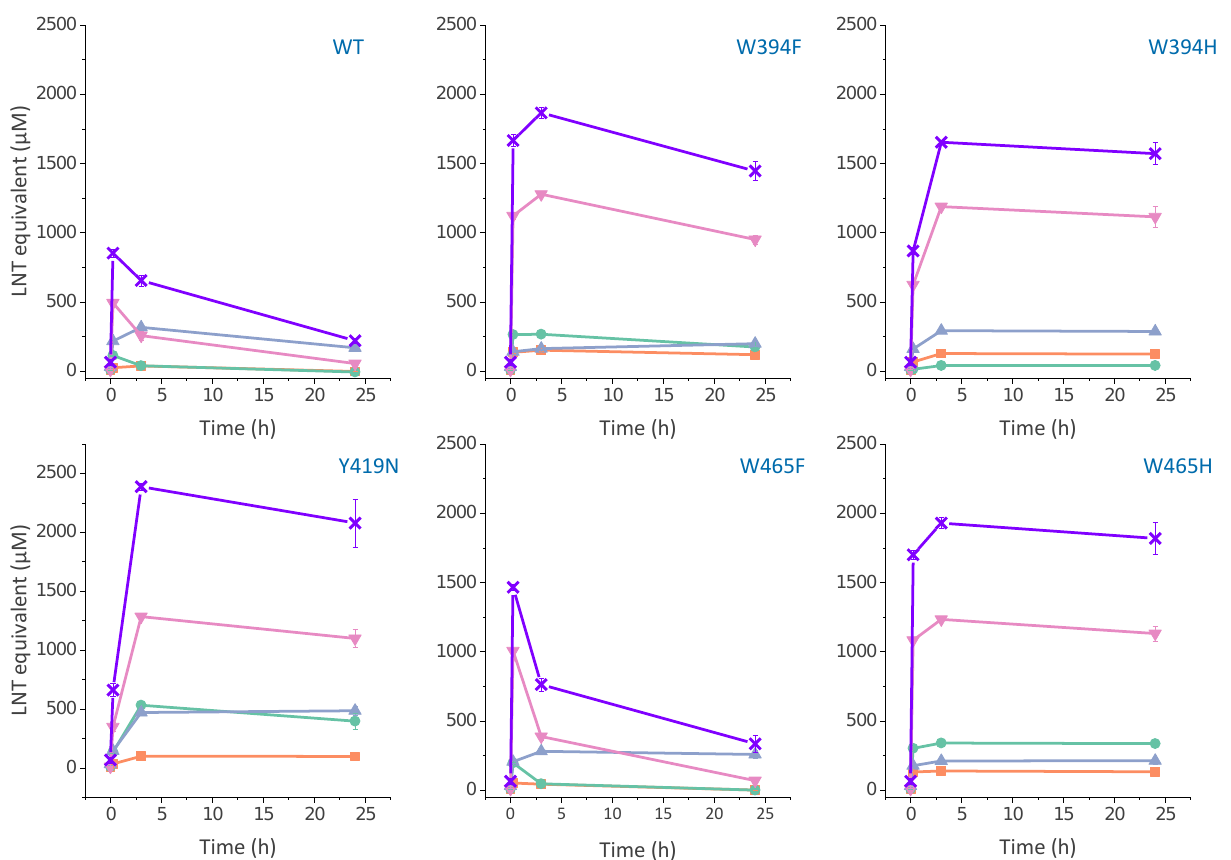
Figure 4. Transglycosylation reactions using LNB-oxazoline as donor and lactose as acceptor at pH 7.4 and 37 °C for WT LnbB and the five best variants (W394F, W394H, Y419N, W465F, and W465H). Similar plots for the other variants are shown in Figure S4. The formation of transglycosylation products was followed over 24 h with LC-MS and quantified as LNT equivalents. Purple crosses represent the total formation of all LNT isomers, while pink triangles represent formation of LNT (LNB-β1,3-Lac), orange squares LNB-β1,2-Lac, green circles LNB-1,1-Lac, and blue triangles LNB-β1,6-Lac.